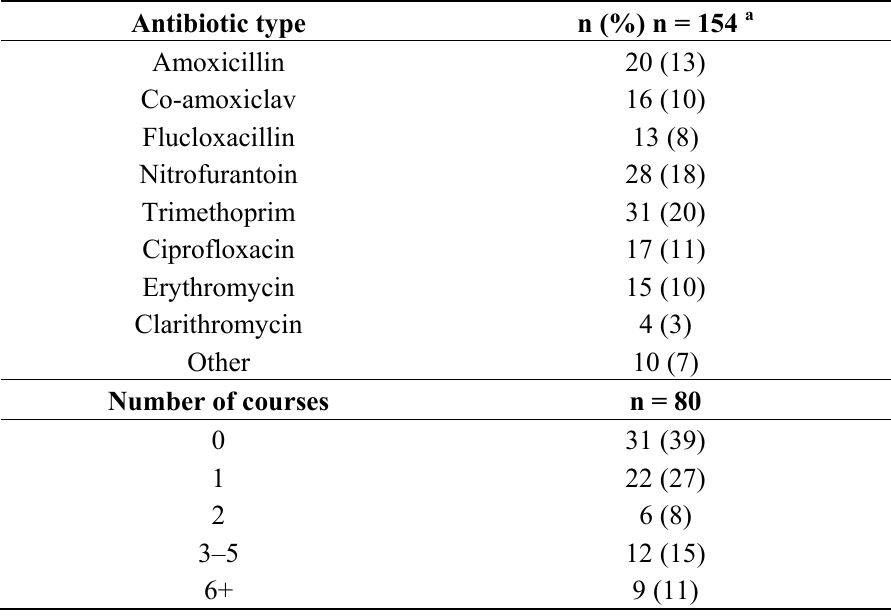
Table 3. Primary care antibiotic courses in the previous 12 months.